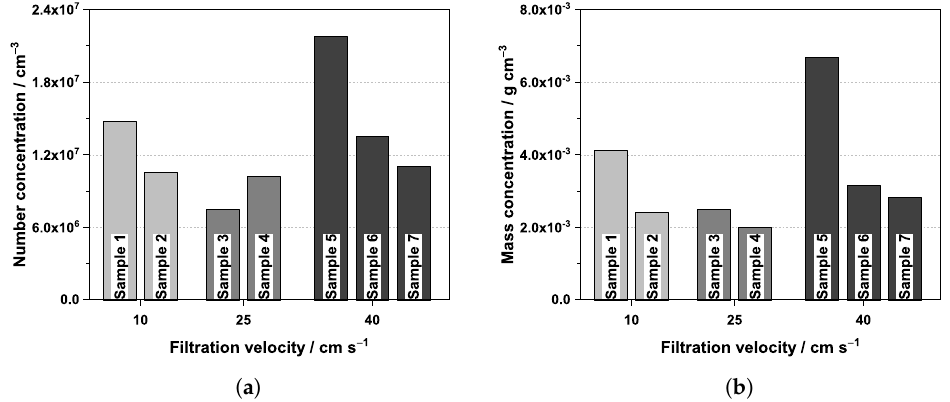
Figure 8. ( a ) Number and ( b ) mass concentration of the identified deposited oil droplets, formed at three different filtration velocities.